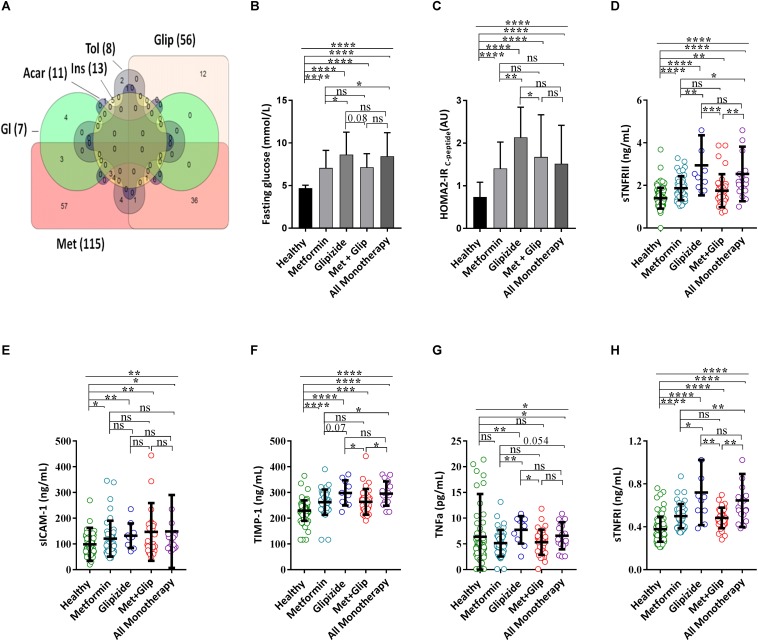
Metformin decrease TNFα associated Systemic Inflammatory molecules. (A) Venn diagram [made using online free software (Bioinformatics and Evolutionary Genomics, 2017)] indicates the combination of drug used for a total of 140 diabetes patients (1 patient take a combination of gliclazide and diabetin is not included in the Venn diagram). Comparison of DM patients with different treatments for fasting blood glucose (B), HOMA2-IRC–peptide
(C), sTNFRII (D), sICAM-1 (E), TIMP-1 (F), TNFα (G), and sTNFRI (H). P-values were calculated using non-parametric Kruskal–Wallis test and Mann–Whitney U-test was used for comparing more than two groups and between two groups, respectively (ns P > 0.05, *P < 0.05, **P < 0.01,***P < 0.001,****P < 0.0001). Acar, acarbose; Glip, glipizide; Gl, glibenclamide; Ins, Insulin; Tol, tolbutamide; Met, metformin.